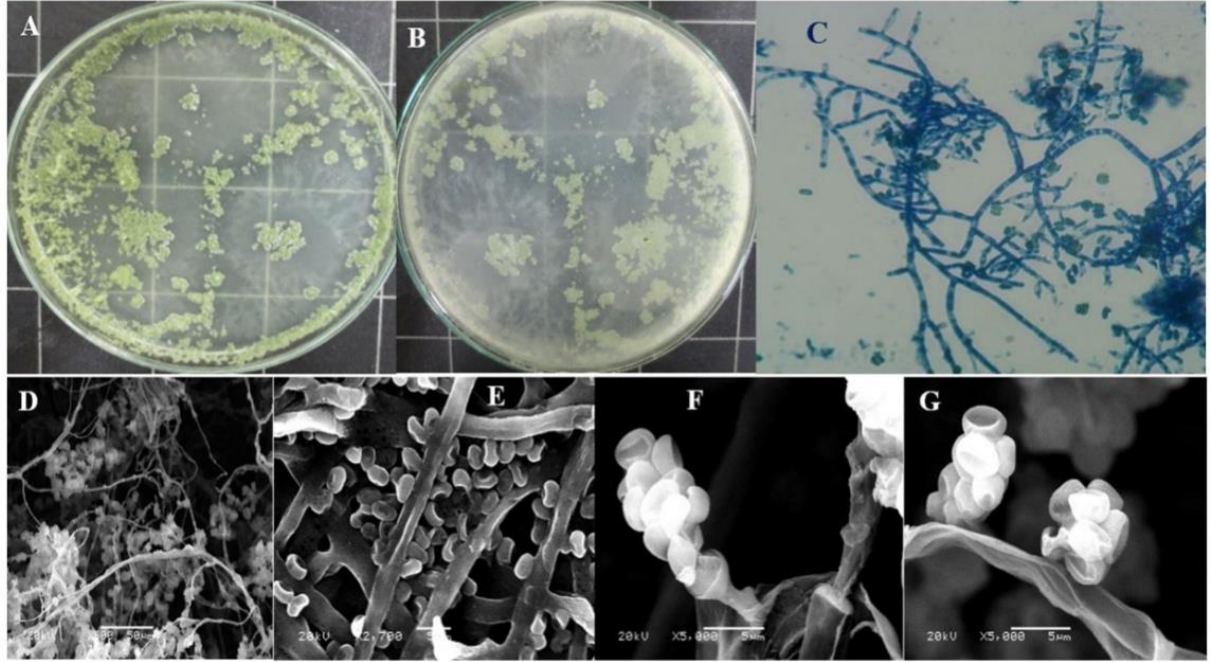
Figure 1. Culture characteristics (( A ) = front and ( B ) = reverse) of Trichoderma harzianum kj831197.1 on PDA media after 5 days of incubation, ( C ): microscopic features of fungal mycelia and spore under the light microscope (40 × ), and ( D – G ): different internal structures of conidia and conidiophore under the scanning electron microscope (500, 2700, and 5000 magnification), respectively.